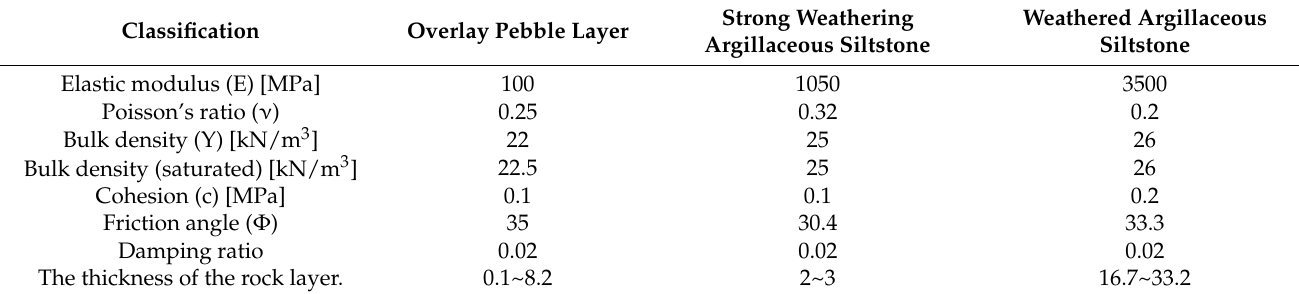
Figure 2. The finite element dynamic analysis model. Table 2. Calculation parameters of the foundation soil.